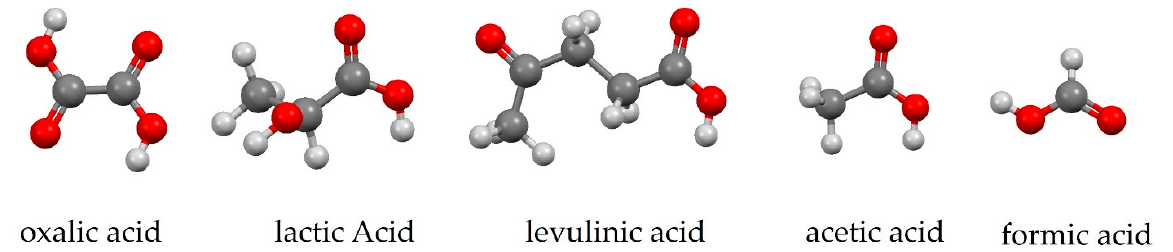
Figure 2. Scheme of products from HPLC analysis for the catalytic conversion of hemicellulose carbohydrates mixtures using the homogeneous H 2 SO 4 catalyst in the liquid phase.